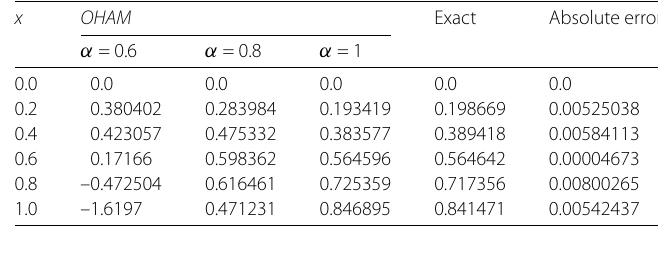
Table 1 Exact and approximate result of Test example 4.1 with various values of α x OHAM Exact Absolute